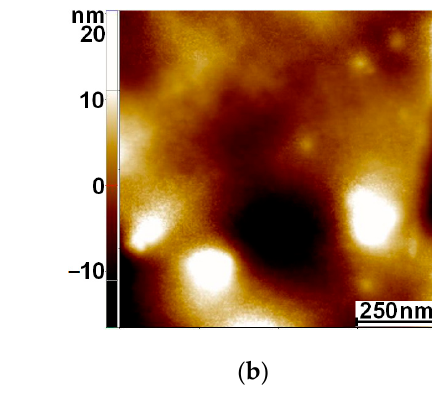
Figure 2. EDS spectra of the Ag–TiO 2 film ( a ) and Au–TiO 2 film ( b ).